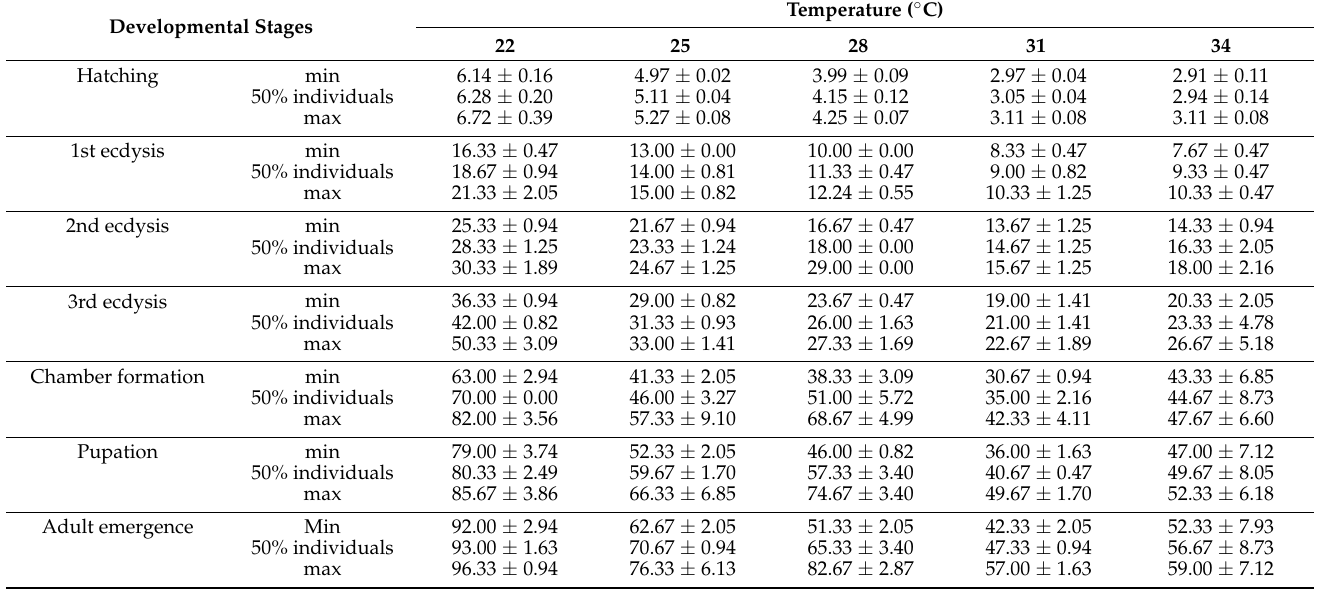
Table 1. Mean duration (days ± SD) of different developmental stages of Necrobia ruficollis under laboratory conditions with five temperatures, a photoperiod of 12:12 h L:D, and humidity of